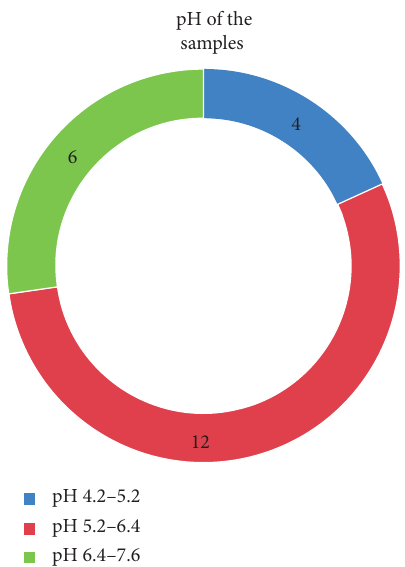
Figure 3: pH measurement of different samples. pH was measured using a pH meter. Among the isolated samples, 4 have the pH between 4.2 and 5.2, 12 have the pH between 5.2 and 6.4, and 6 have the pH between 6.4 and